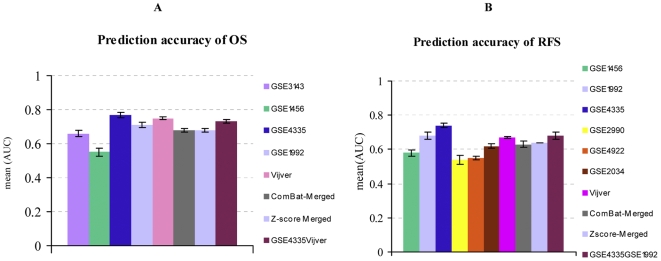
The prediction accuracy of the gene signatures generated from the breast cancer merged and single data sets.The results present the average of the Area Under the Curve (AUC) over 10-fold cross validation. The error bars represent the standard deviation of AUC over 10 iterations. Figure 5A: GSE3143: 0.66+/−0.03, GSE1456: 0.55+/−0.04, GSE4335: 0.77+/−0.02, GSE1992: 0.70+/−0.05, Vijver: 0.75+/−0.01, ComBat-merged: 0.68+/−0.03, Zscore-merged: 0.68+/−0.01, GSE4335Vijver: 0.73+/−0.02. Figure 5B: GSE1456: 0.58+/−0.02, GSE1992: 0.67+/−0.03, GSE4335: 0.74+/−0.03, GSE2990: 0.54+/−0.04, GSE4922: 0.55+/−0.02, GSE2034: 0.62+/−0.02, Vijver: 0.67+/−0.01, ComBat-merged: 0.63+/−0.01, Zscore-merged: 0.64+/−0.00, GSE4335GSE1992: 0.68+/−0.02.